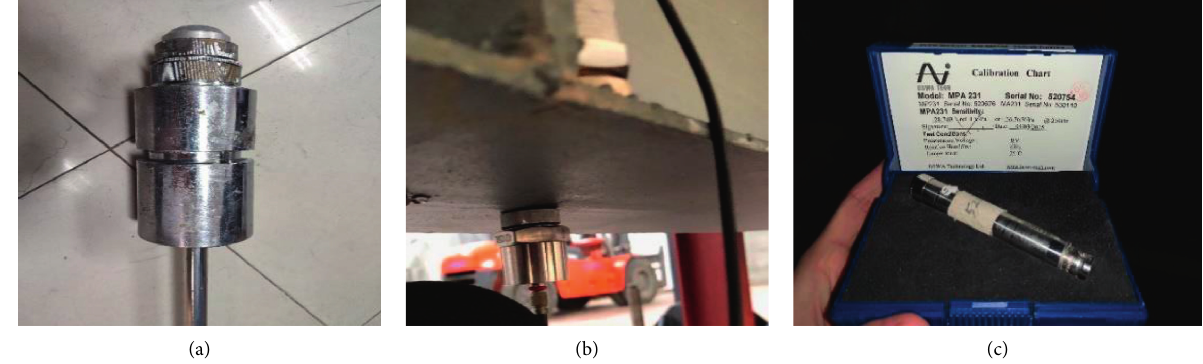
Figure 4: Test equipment. (a) Hammer. (b) Vibration acceleration sensor. (c) Sound pressure sensor.